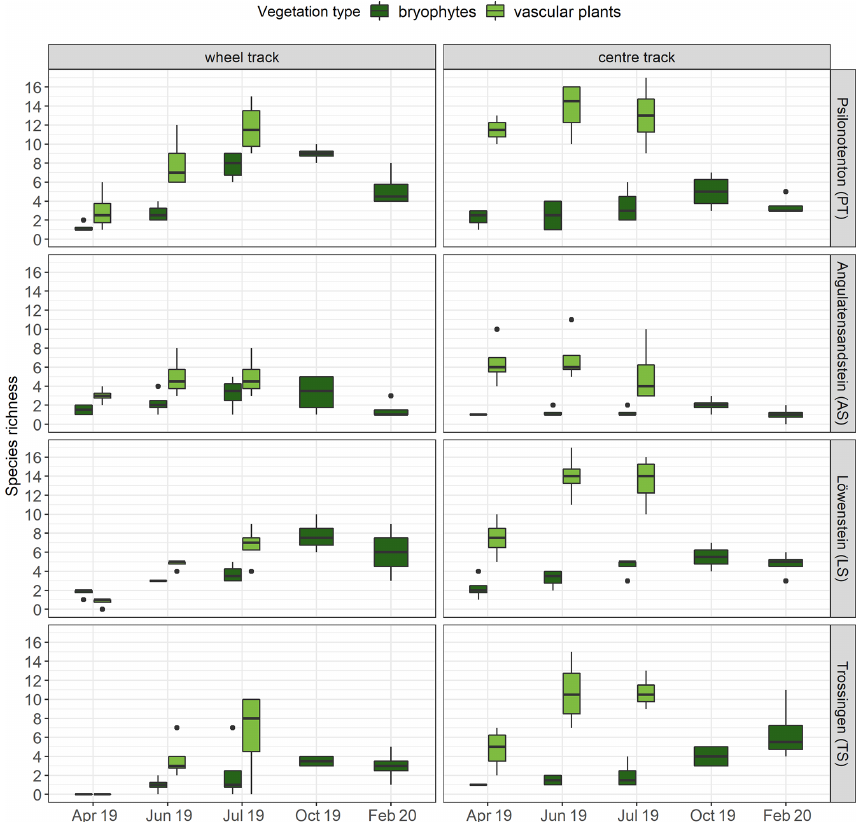
Figure 4. Species richness of bryophytes ( n = 4) and vascular plants ( n = 4) per runoff plot at the individual skid trails. The bottom and top of the box represent the first and third quartiles, and whiskers extend up to 1.5 times the interquartile range (IQR) of the data. Outliers are defined as more than 1.5 times the IQR and are displayed as